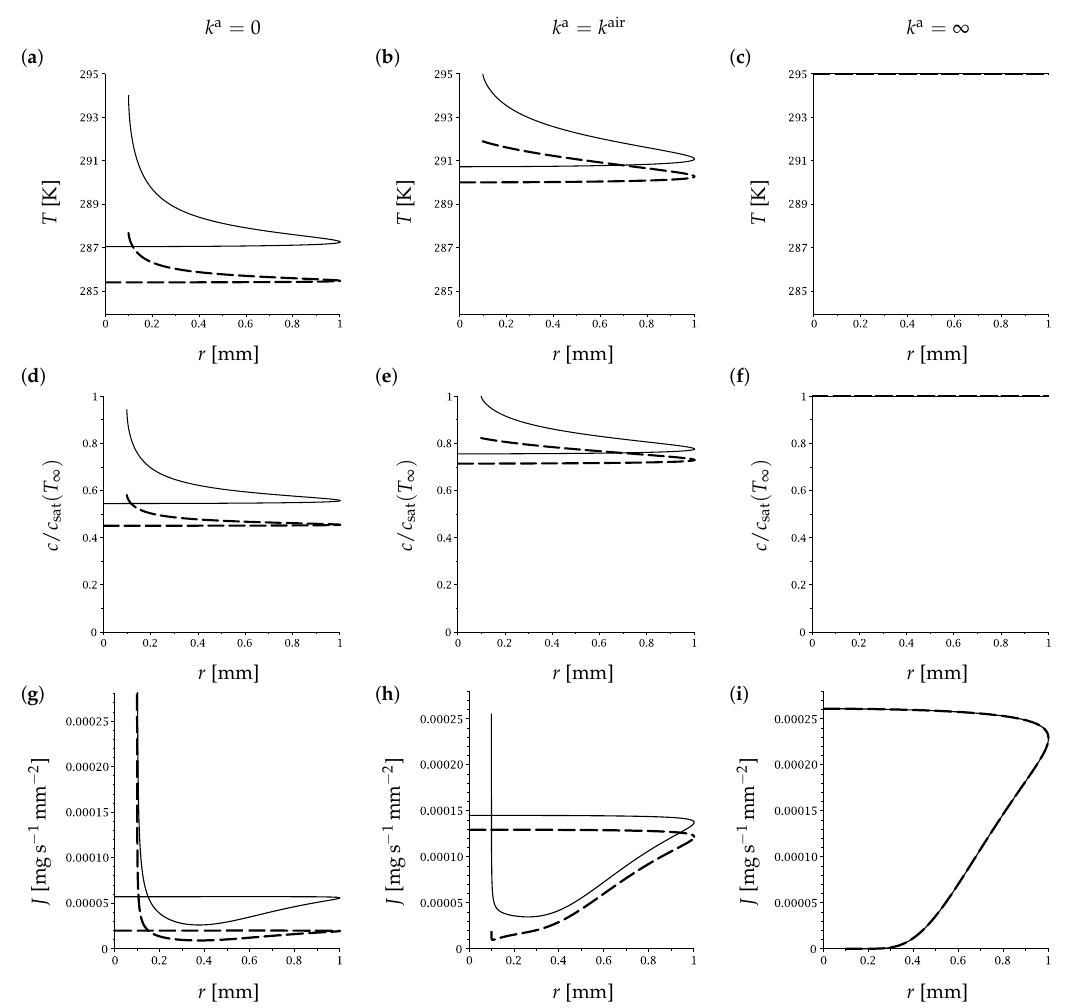
Figure 5. Numerically calculated solutions for ( a – c ) the temperature along the free surface of the droplet, ( d – f ) the vapour concentration along the free surface of the droplet, and ( g – i ) the evaporative flux for a droplet of water with contact angle θ = π 0.1 and contact radius R = 0.1 mm evaporating into atmospheres with T ∞ = 295 K and thermal conductivities − 10 − 2 Wm − 1 K − 1 [column ( b , e , h )] and k a = ∞ [column ( c , f , i )] on an aluminium k a = 0 [column ( a , d , g )], k a = k air = 2.597 × substrate ( k s = 2.73 10 2 Wm − 1 K − 1 , solid curves) and a PTFE substrate ( k s = 0.25 Wm − 1 K − 1 , dashed curves). All of × the results are obtained using n = 1 in Equation